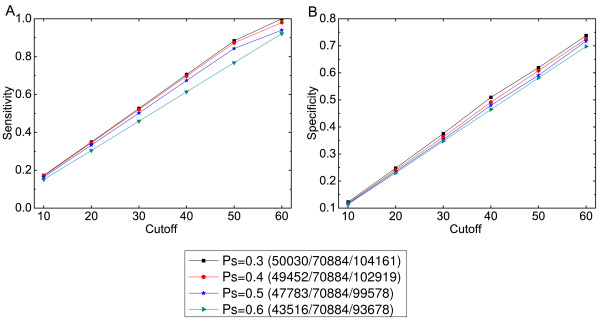
Performance of our method DLaNe with different peak significance (Ps) values. Here we present the results of four thresholds at six different distance cutoff values from 10 to 60. (A) Sensitivity. (B) Specificity.